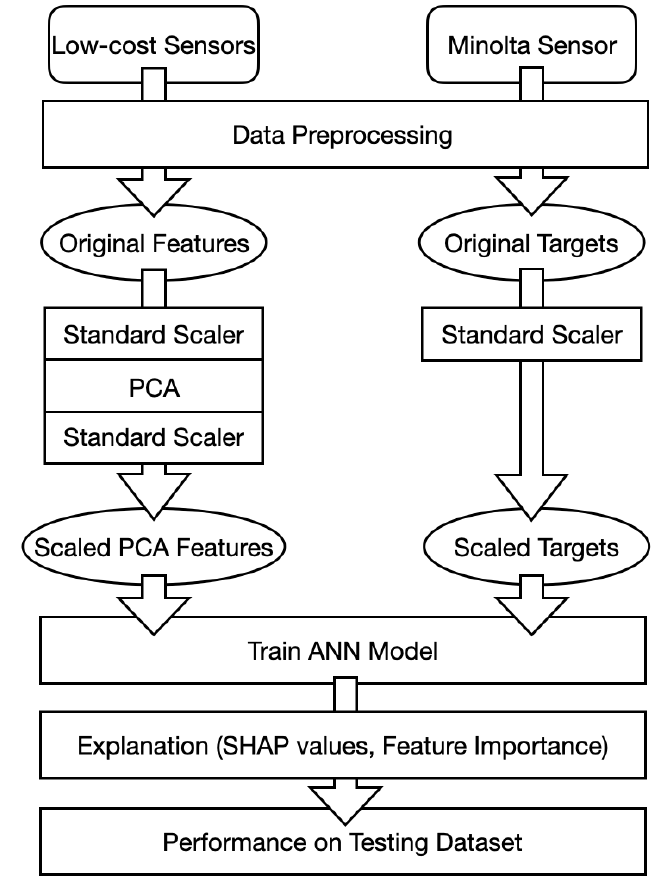
Figure 6. Workflow of the light sensor